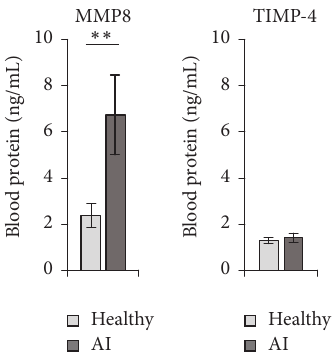
Figure 4: MMP8 levels are markedly increased in the blood of AI patients. MMP8 and TIMP-4 blood plasma levels of 20 healthy control donors and 21 AI patients were analyzed by ELISA. Mean data ± SEM are shown. Significance of differences was analyzed using the Mann-Whitney U test (two-tailed; ∗∗ 𝑃 < 0.01